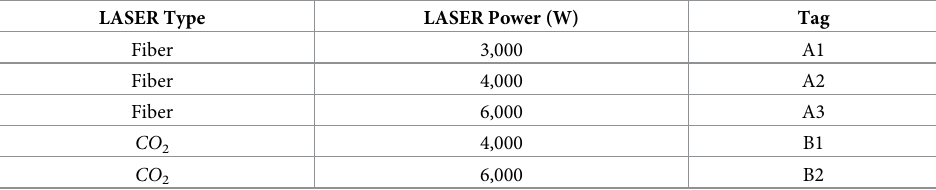
Table 2. LASER cutting machines